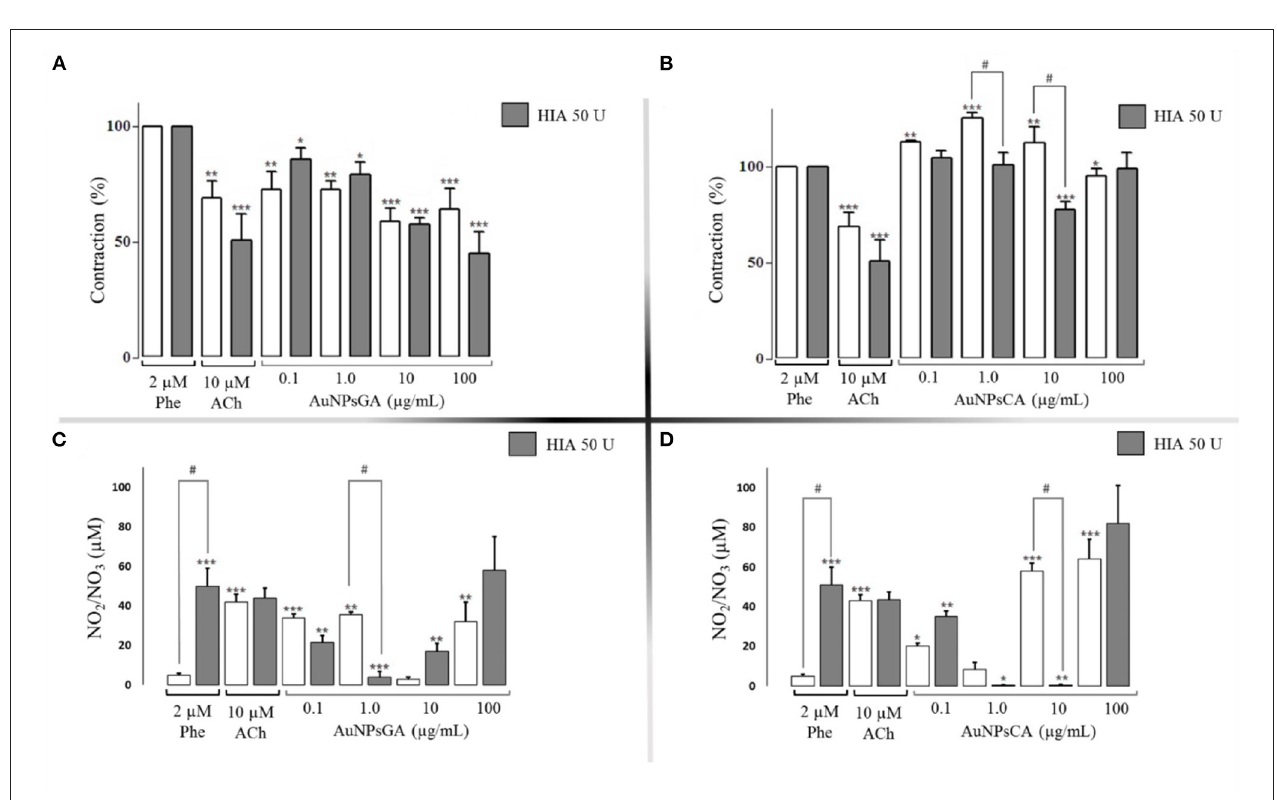
FIGURE 3 | rings with Phe 2 µ M, calculated as the percentage of tension based on 100% contraction induced by Phe 2 µ M. NO production, in absence and presence of AuNPsGA (0.1, 1, 10, and 100 µ g/mL) (K) and AuNPsCA (0.1, 1, 10, and 100 µ g/mL) (L) was determined by Griess method. Values are representing as